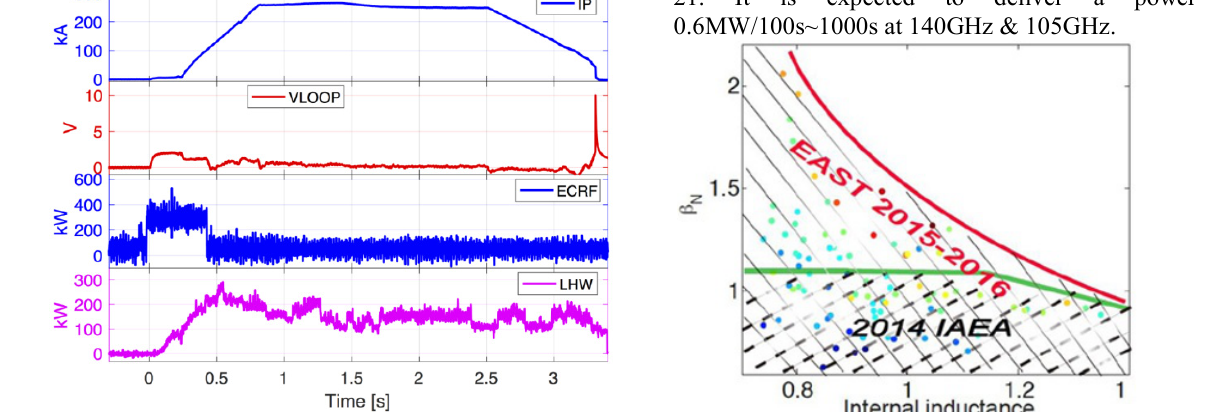
Fig. 20. The β N in the relationship with internal inductance.